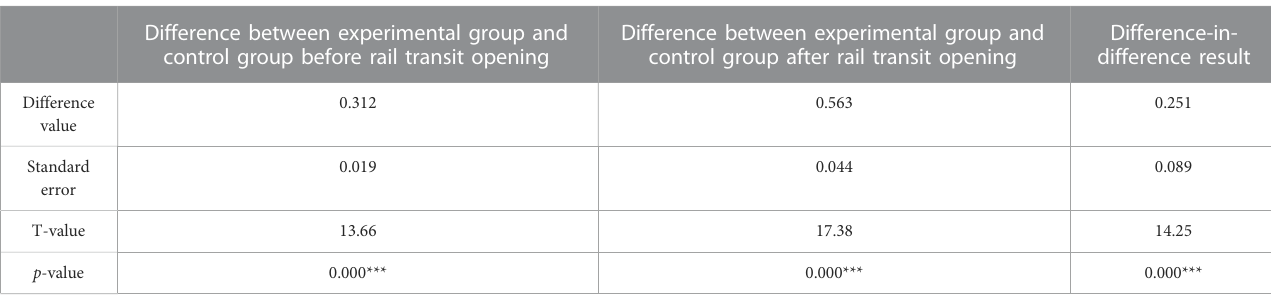
Difference between experimental group and control group after rail transit opening